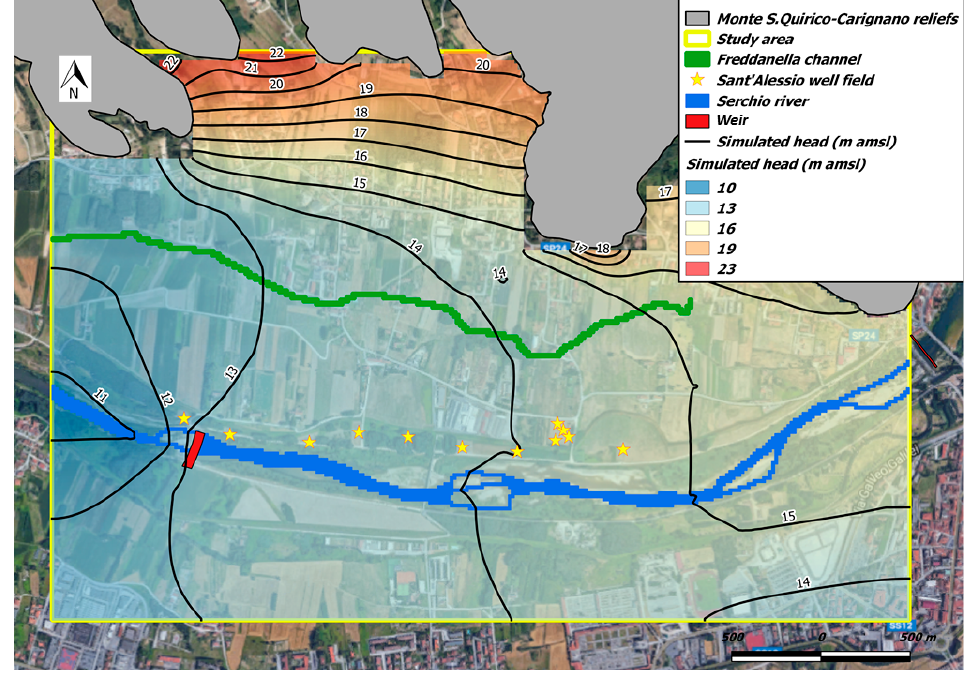
Figure 9. Simulated hydraulic head at the end of May 2016.